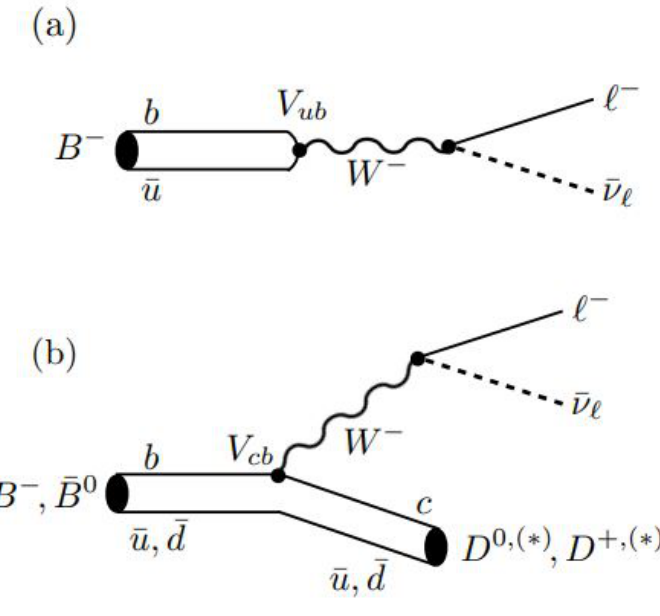
Figure 2. Tree -level decay processes: ( a ) B − → l − ¯ ν l [81], ( b ) B − → D ∗ l − ¯ ν l